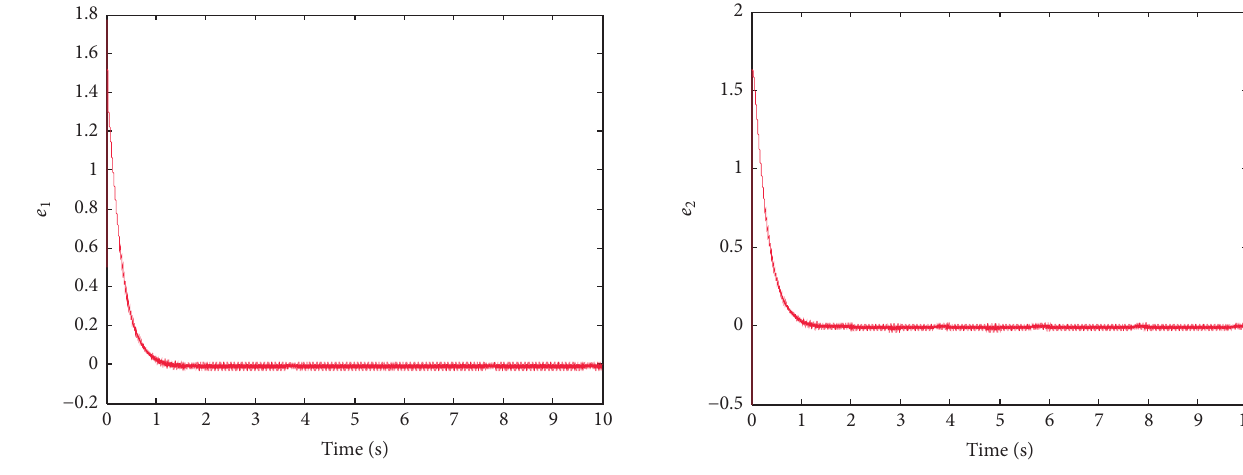
Figure 4: Tracking error 𝑒 2 of input signal 2.